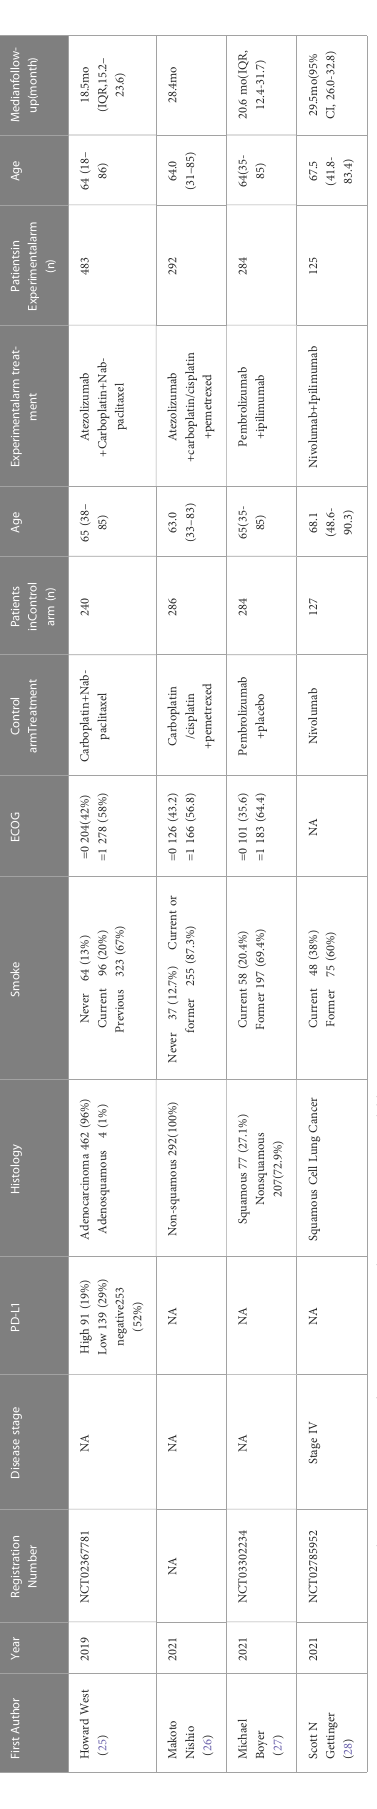
FIGURE 3 Network plots of different ICI comparisons. Single drug and drug combination comparison network. The size of each node is proportional to the number of participants (sample size). The lines represent the direct comparison available between treatment pairs, and the line width is proportional to the number of trials comparing each pair of